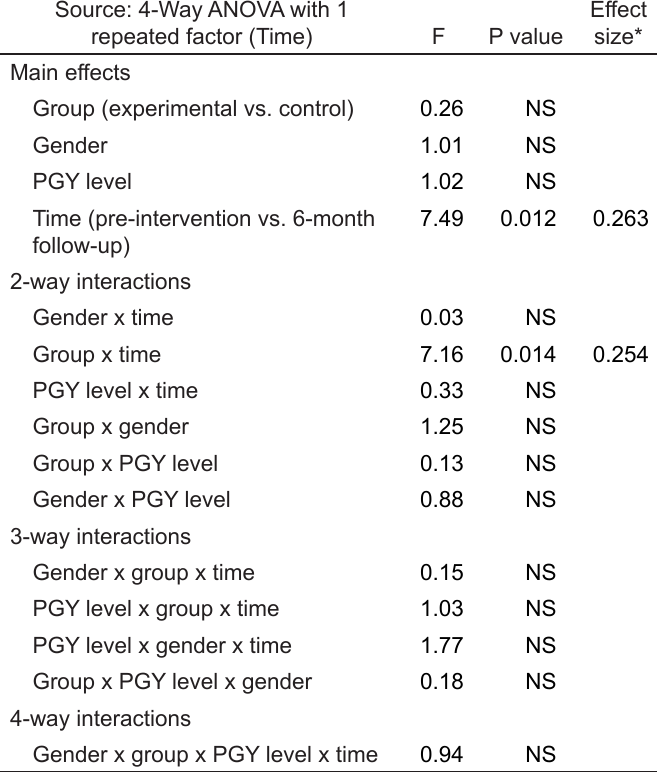
Table 2. Analysis of variance (ANOVA) results of emotional intel- ligence measures of 33 emergency medicine residents comparing intervention group, gender and program year level (PGY) at two time periods: Before Intervention, and six-months